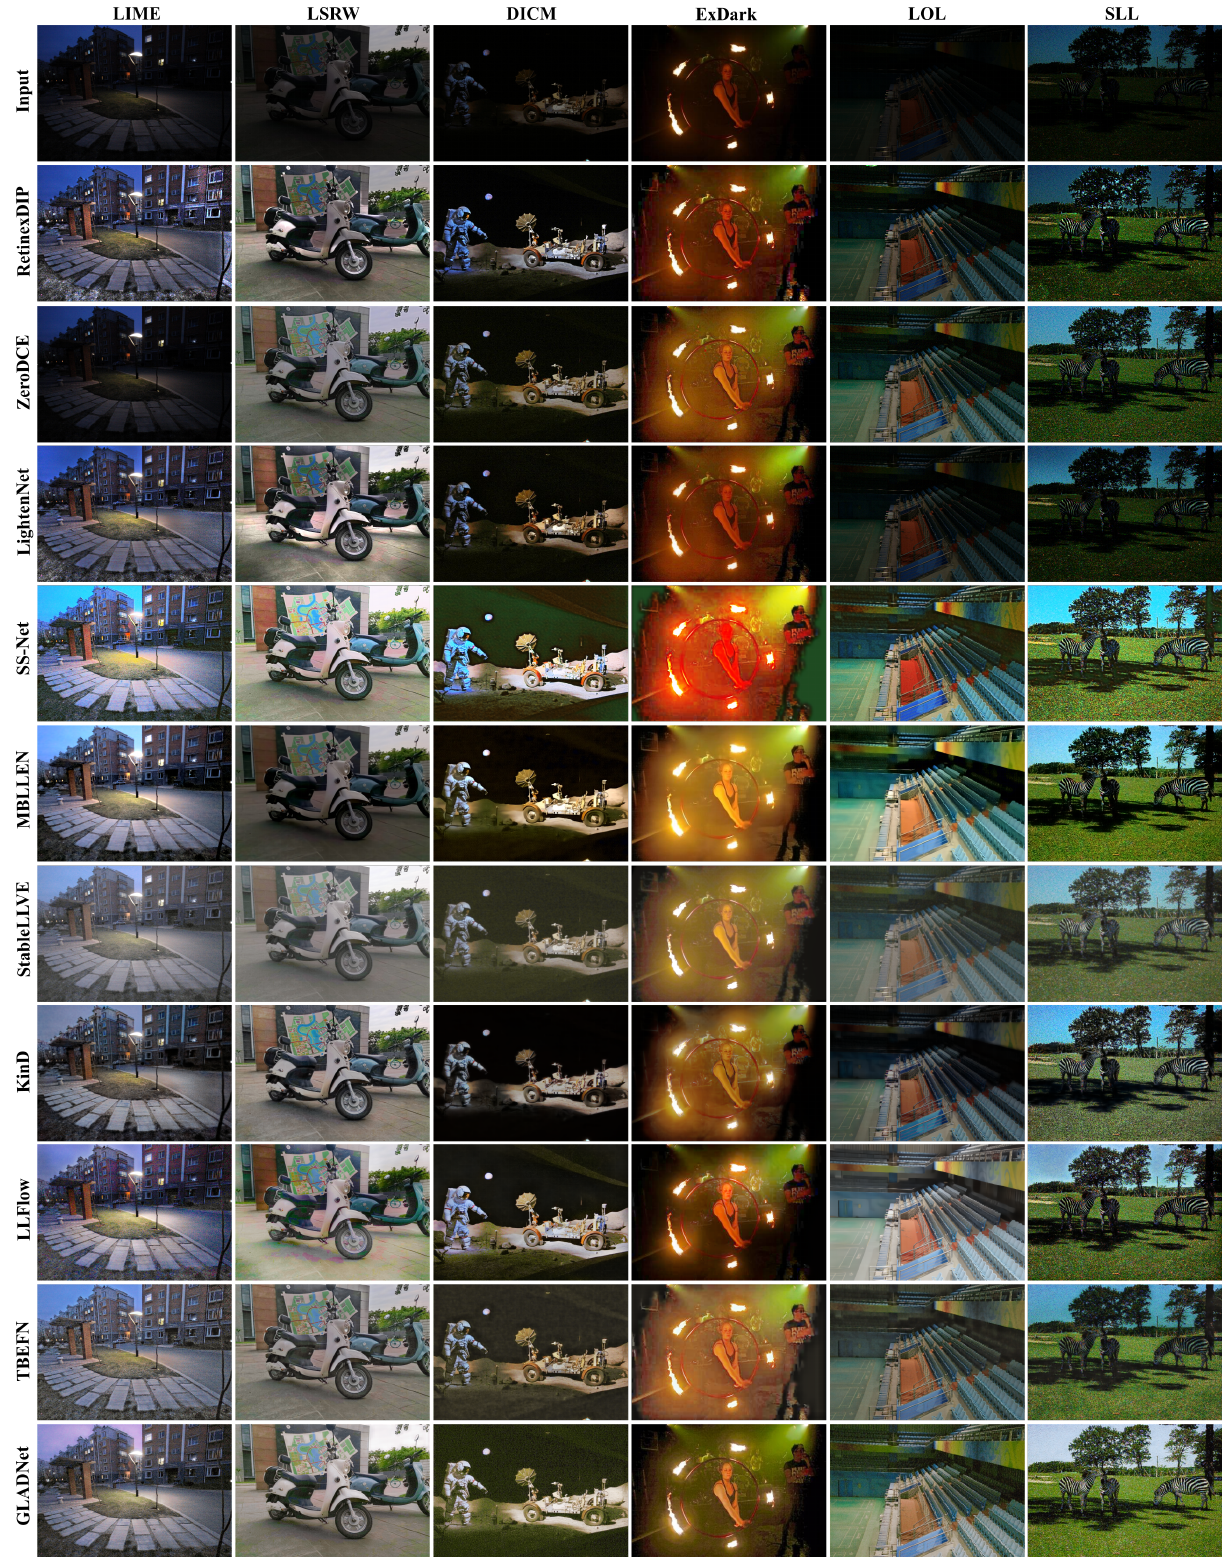
Figure 1. A visual representation of results from top ten deep learning methods on six datasets. The rows are showing the results produced by different algorithms, whereas the columns are showing